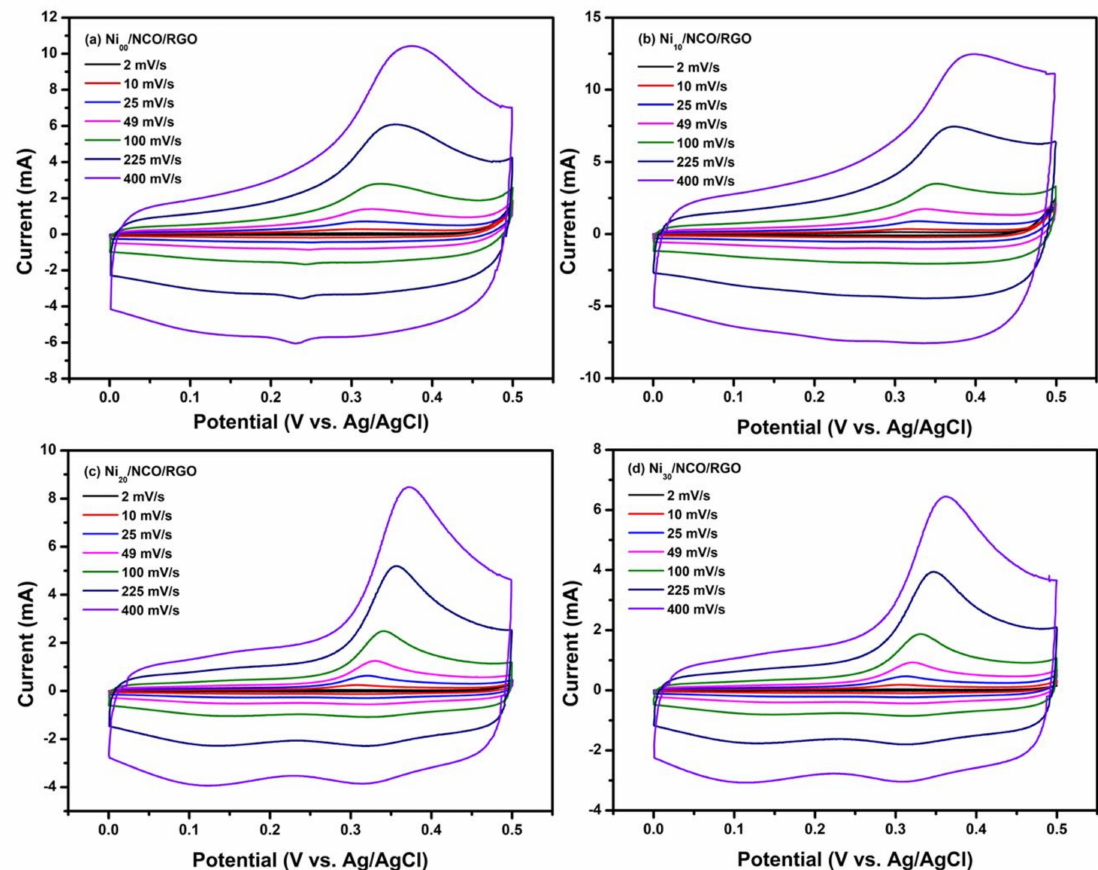
Figure 6. Cyclic voltammetry CV curves of different Ni/NCO/RGO electrodes at various scan rates under 0–0.5 V potential